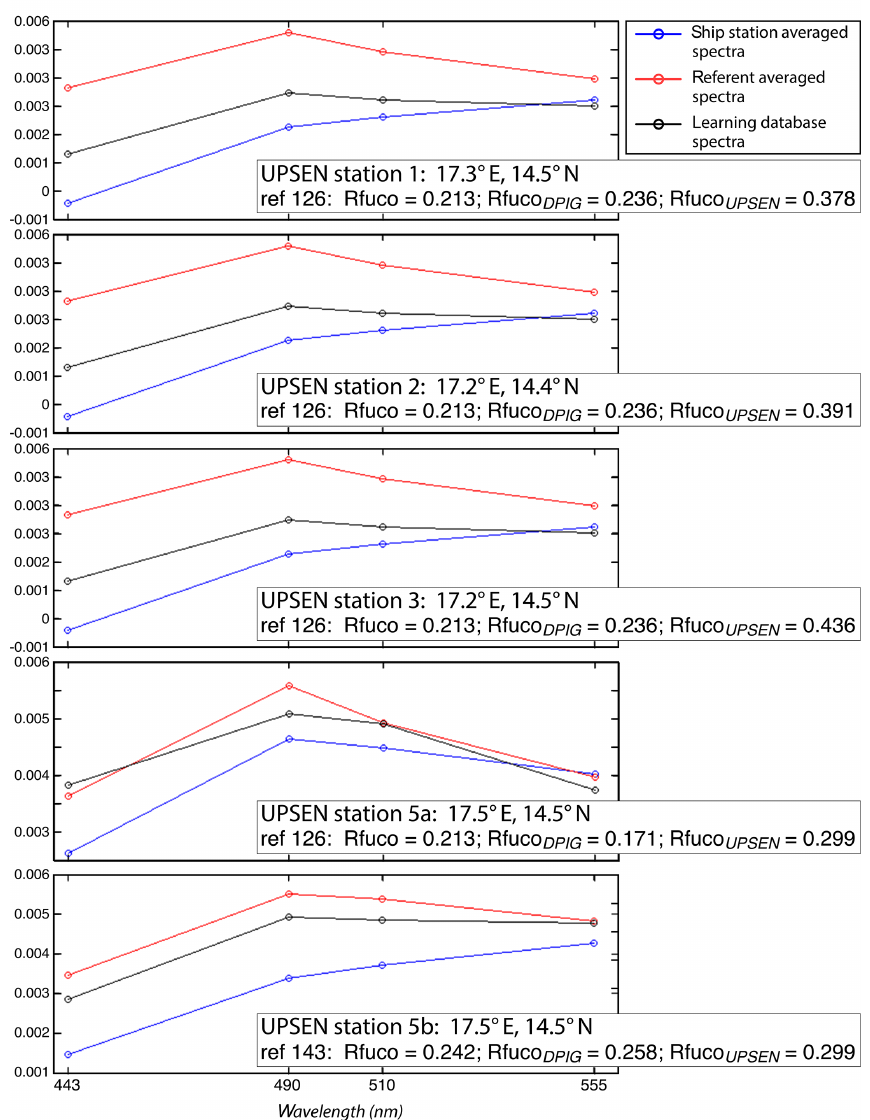
Figure 16. For ship stations 1, 2, 3, 5a and 5b, we show the averaged spectrum of the in situ spectra of the UPSEN stations in blue and the spectrum of the referent vector (in red) of the 2S-SOM neuron that has captured the closest satellite observations to the UPSEN station. Among the different spectra constituting the referent spectrum, the spectrum of the learning database (DPIG) that is the closest to the averaged satellite spectra is shown in black. In the rectangular boxes, we show the position of the UPSEN station, the number of the neuron of the 2S-SOM that has captured the satellite observation, the Rfuco of the referent vector, the Rfuco DPIG of the closest DPIG and the in situ Rfuco UPSEN